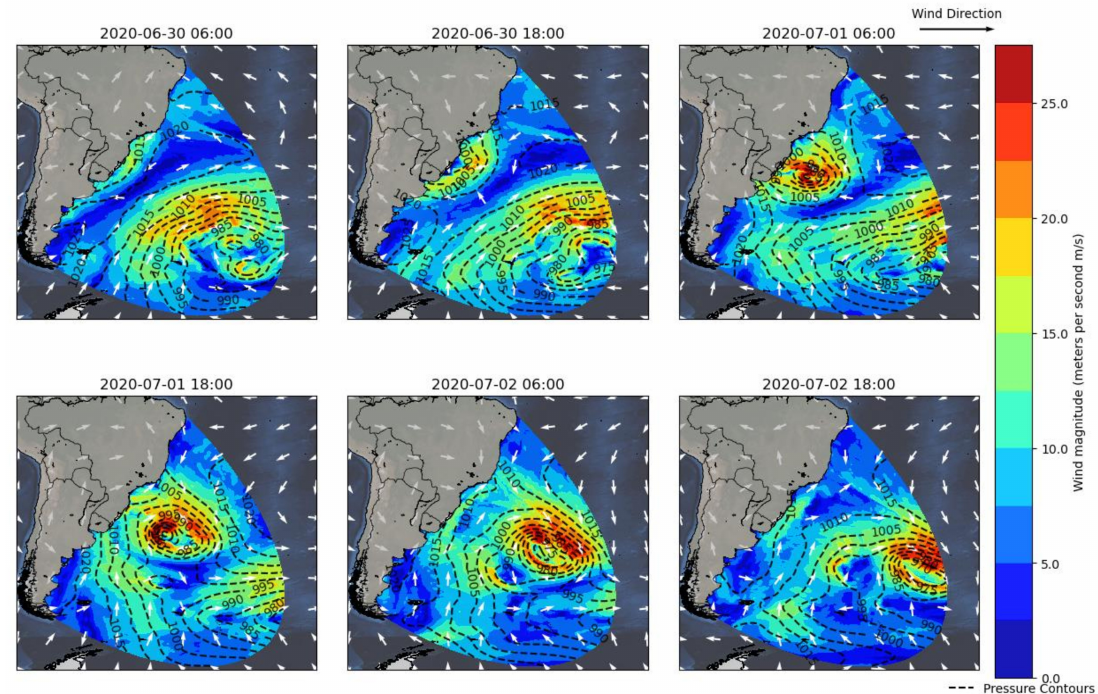
Figure 3. Global Forecast System-model-forecasted wind and pressure fields for the bomb